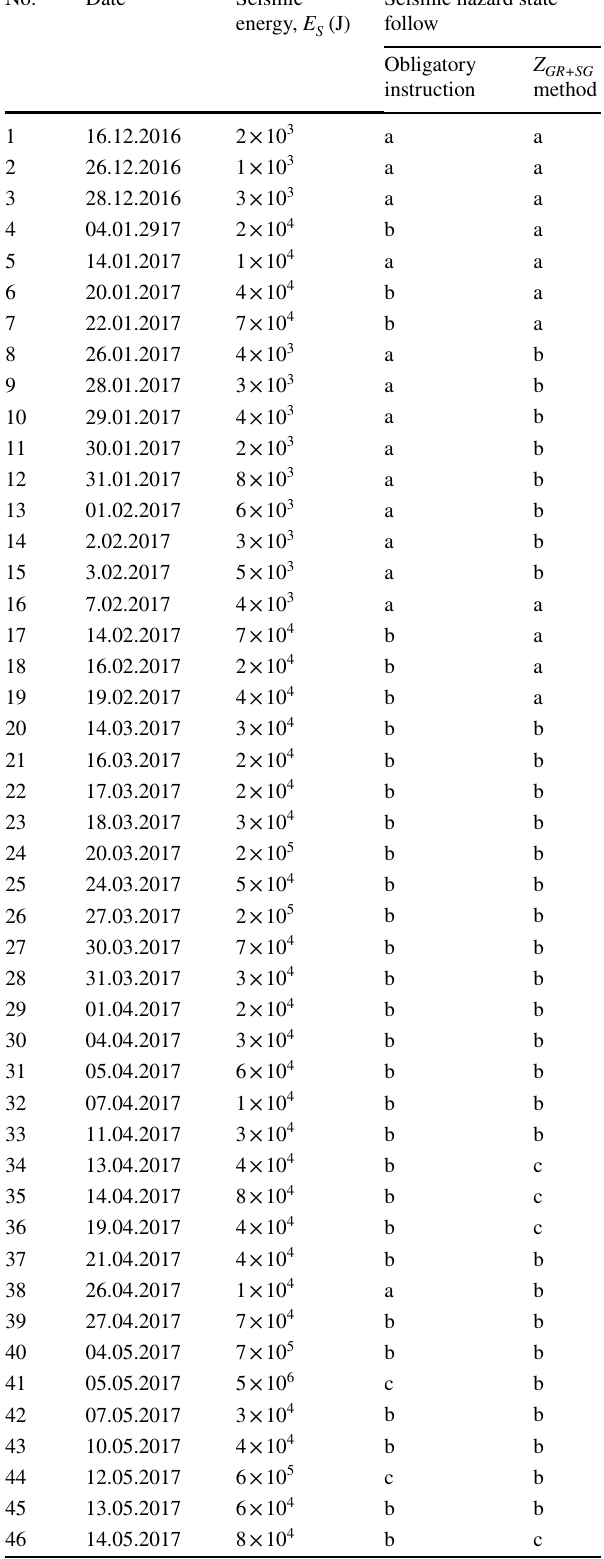
Table 6 Credibility assessment of the elaborated method z seismic hazard